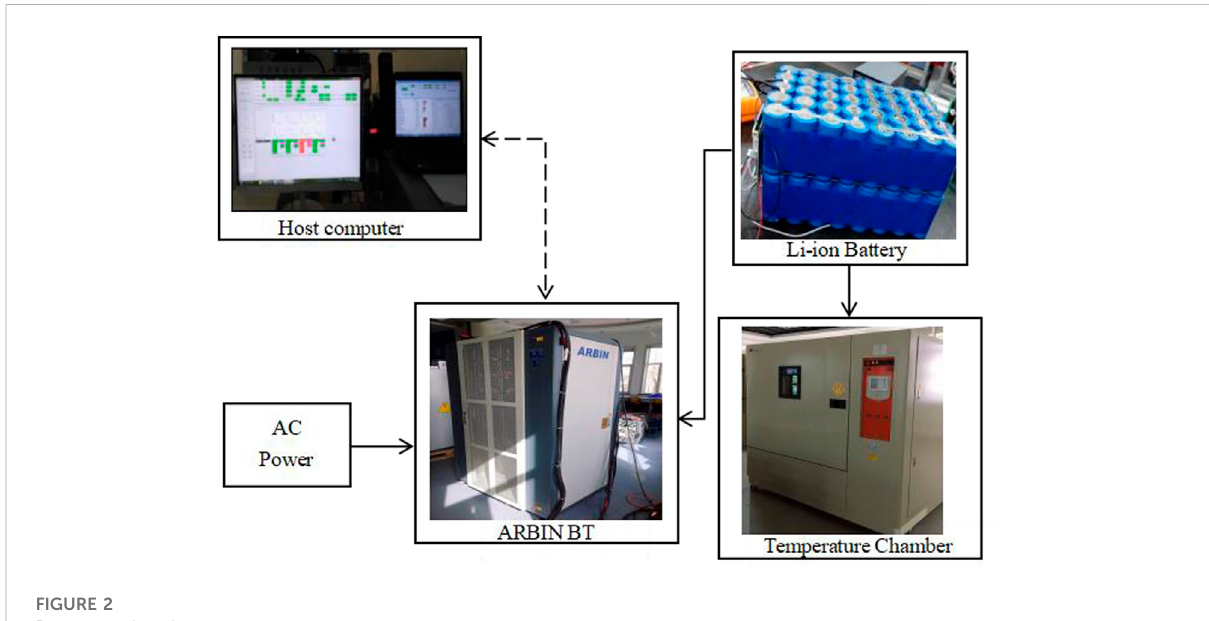
FIGURE 2 Battery test bench.